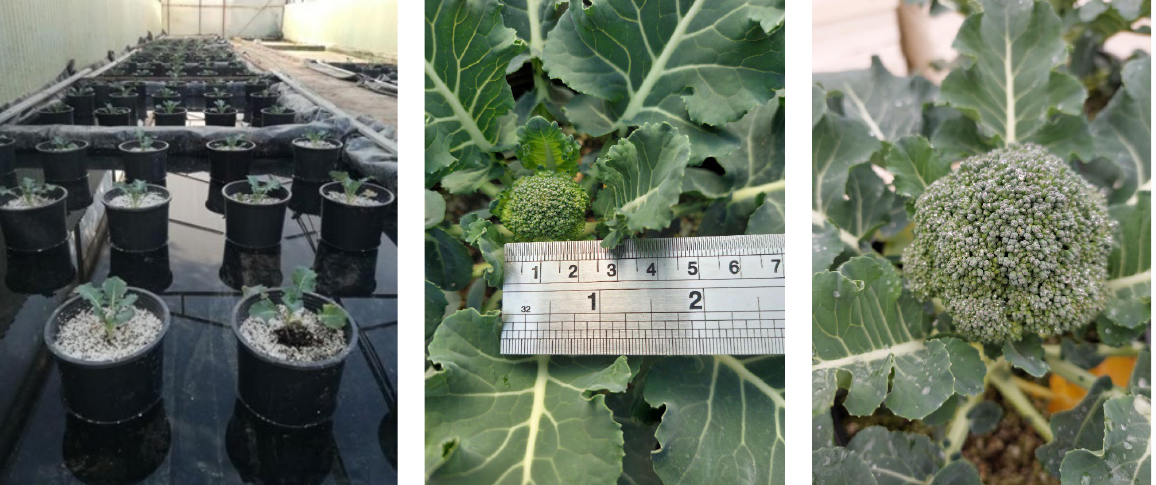
Figure 1. In the left picture are plants after transplantation (stage 14–15 of BBCH scale), along with a broad view of the hydroponics cultivation. In the middle picture is a floret at the beginning of the growth period when the florets were 1–2 cm in width (day 73 post-transplantation, when treatments took place). Each treatment was applied once. In the right is a closer picture of the floret and the leaves. No visual symptoms of any kind were observed during the cultivation period.